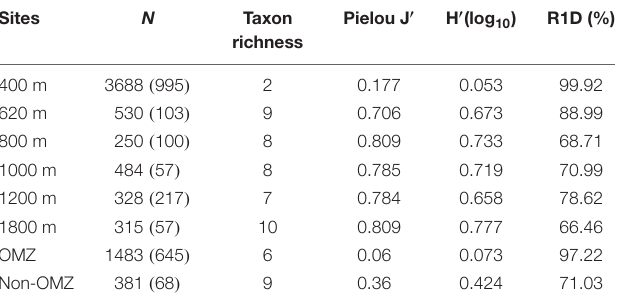
TABLE 4 | Mean density, taxon richness, Pielou’s evenness (J (cid:48) ), Shannon–Wiener (H (cid:48) ) and rank 1 dominance (R1D) for meiofauna (0–10 cm).